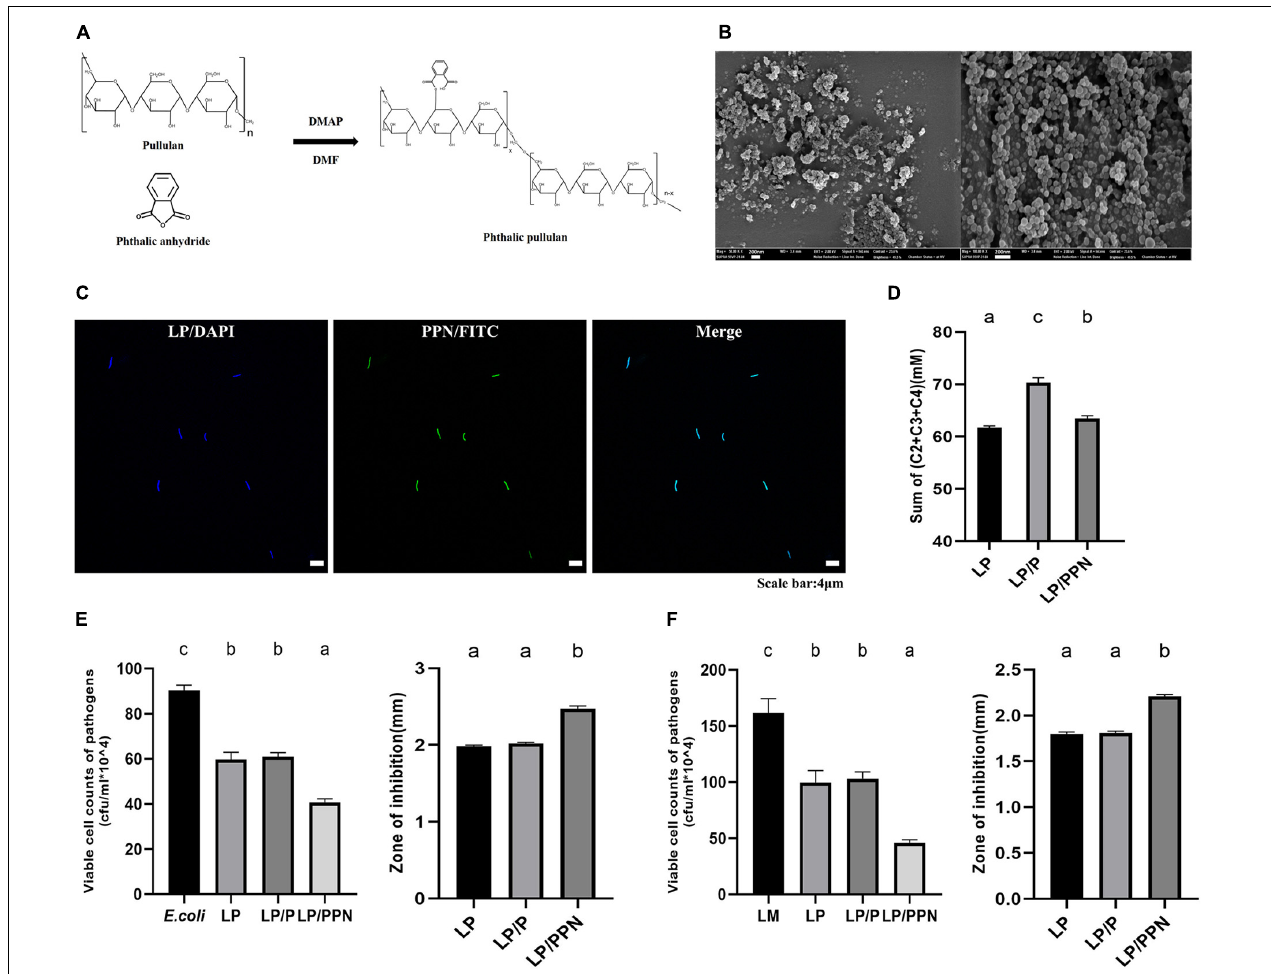
FIGURE 1 | Synthesis and characterization of PPNs. Chemical reaction scheme for the synthesis of PPNs (A) . Morphologies of PPNs were observed by scanning electron microscopy (SEM; magnification: 100.00k, scale bar = 200 nm) (B) . Analysis of the internalization of PPNs into LP observed by confocal laser scanning microscopy (CLSM) (C) . The sum of SFCA amount when culturing probiotics LP alone (LP) or treated with pullulan (LP/P) or PPNs (LP/PPN) was measured using gas chromatography (D) . Antimicrobial activity of probiotics LP when treated with pullulan (LP/P) or PPNs (LP/PPN) against Escherichia coli (EC) (E) and LM (F) . One-way ANOVA with Tukey’s post hoc test was used to determine significant differences among groups. Different superscript letters indicate statistical significance ( p <